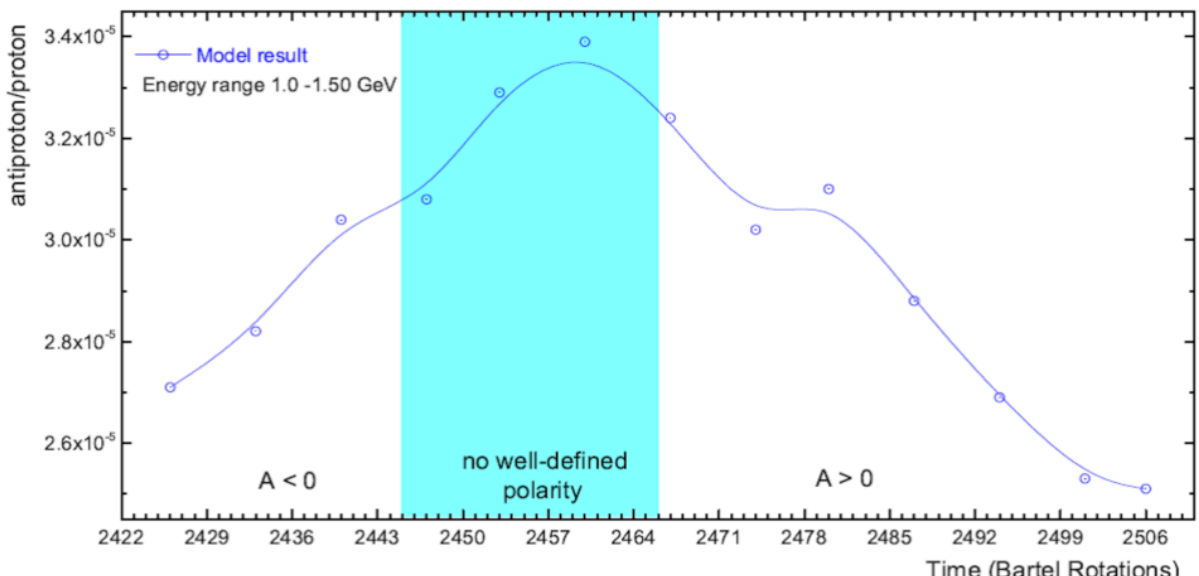
Figure 19. Computed anti-proton to proton ratio as a function of time for 1.0-2.0 GeV at the Earth, here normalized to the value in 2006b. Points indicate model results, interpolated and smoothed as indicated by the solid line. The HMF reversal period with no well-defined polarity is indicated as before. How solar activity has progressed over this period, is shown in Figure 1.